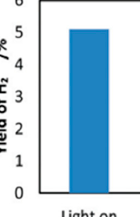
Figure 32. Comparison of activity under light irradiation conditions (surface temperature = 316 °C, operating temperature = 210 °C) vs. dark condition (surface temperature = operating temperature = 316 °C). Reproduced from [22] with permission from The Royal Society of Chemistry.